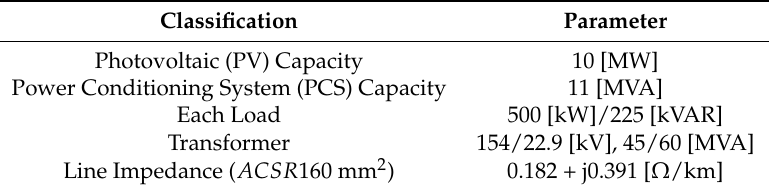
Table 1. Parameters of Test